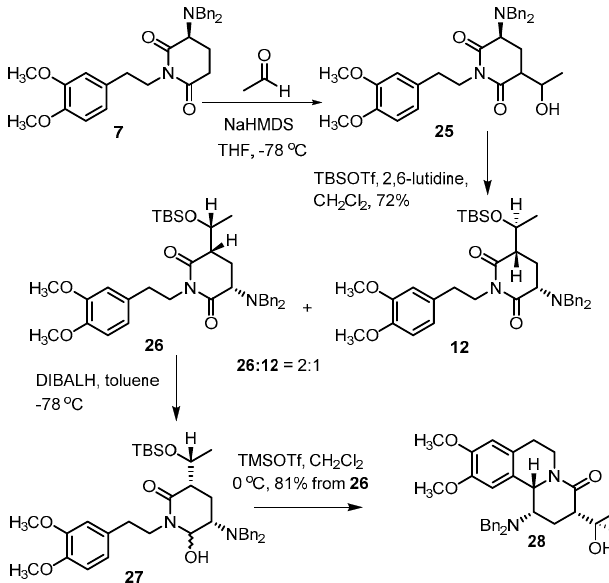
Scheme 11. Synthesis of benzoquinolizidinone